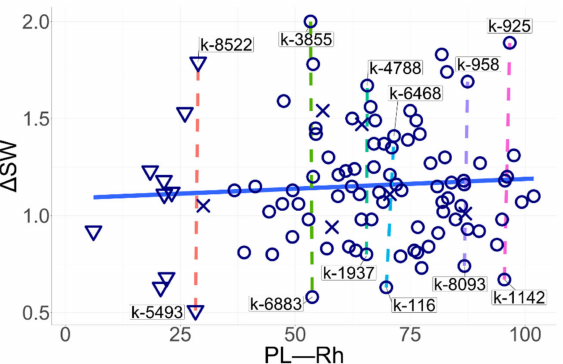
Figure 7. Scatter plot displaying the AM-derived increments for cultivars of different shoot lengths. Dashed lines suggest pairs that could be crossed for genetic analysis of genetic factors determining symbiotic